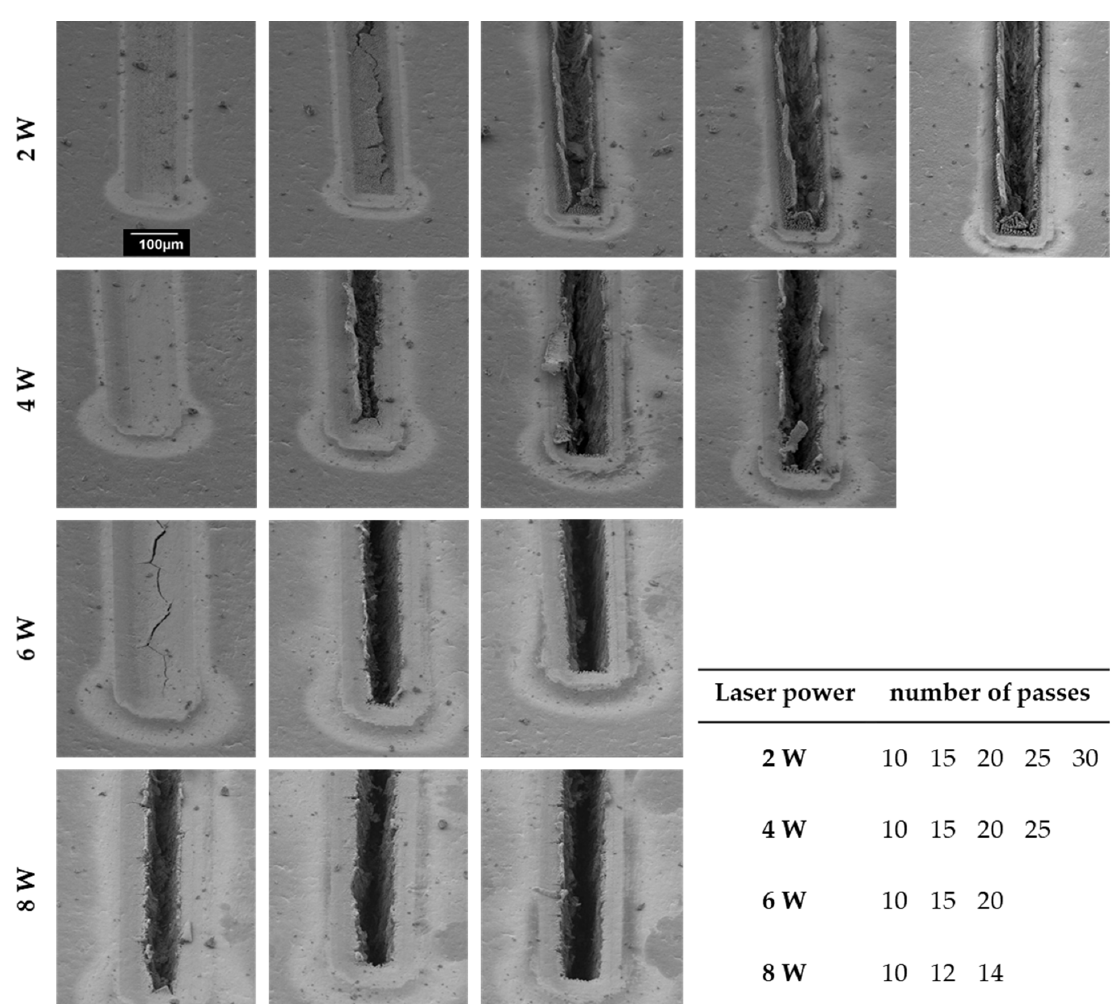
Figure 4. Scanning electron microscope images of laser-ablated nickel layers with varying laser power and corresponding numbers of passes. The images show a test specimen with a 15 µm thick electroplated nickel layer and a cut width of 100 µm. Table 2. Results of the parameter variation of the laser ablation process. The table gives an overview of the number of passes needed to fully ablate the electroplated nickel layer in the desired area depending on layer thickness, cut width and laser power.